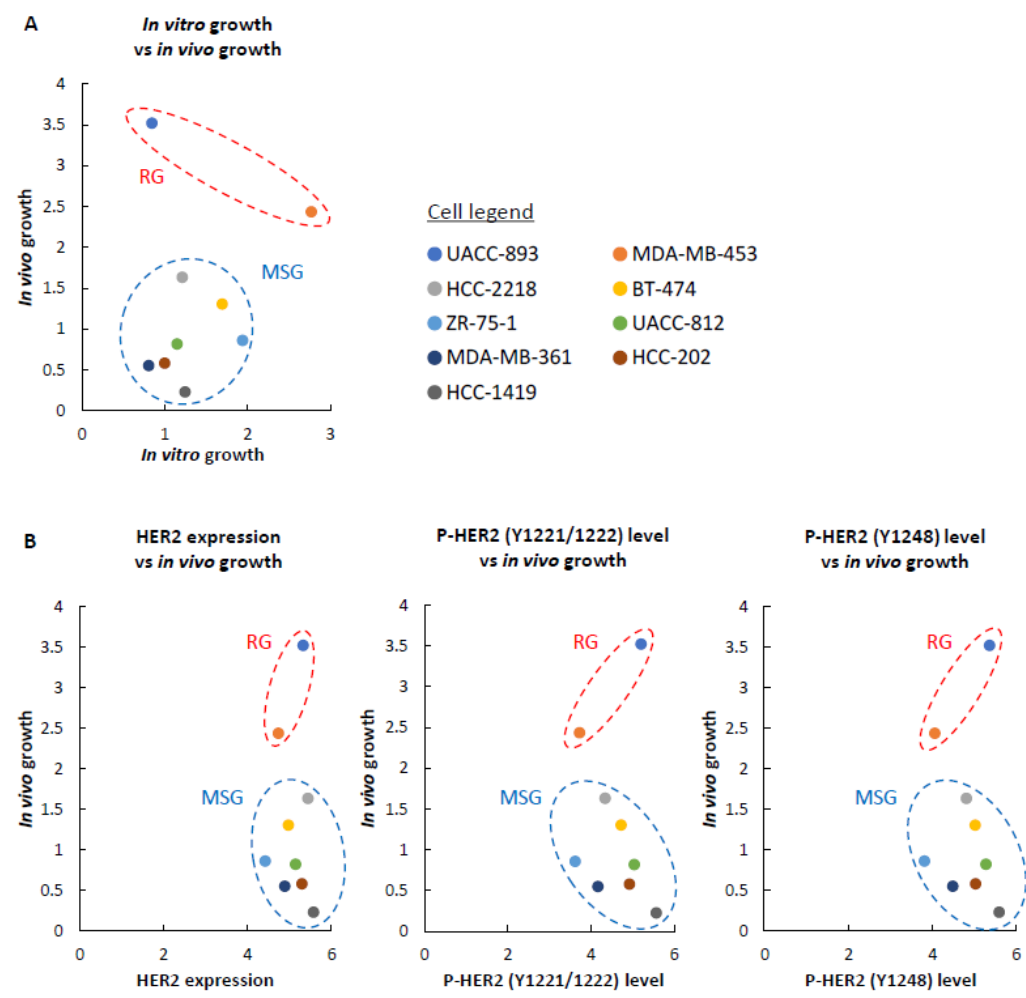
Figure 2. The relationship between in vivo growth and in vitro growth, in vivo growth and HER2 profiles. In all graphs, the vertical axis represents in vivo growth, which is presented on a log10 scale (mean normalized average radiance (ratio) on day 28). ( A ) The relationship between brain-colonizing ability and proliferative activity in vitro. The horizontal axis represents in vitro growth. The cell number on day 4 was converted to a log2 (N(4) / N 0 ) value for three replicates and their mean value was defined as in vitro growth. N(4) = The cell number on day 4. N 0 = The number of cells seeded on day 0 ( = 1.5 × 10 5 cells). ( B ) The contribution of HER2 expression and HER2 phosphorylation to growth activity in vivo. The horizontal axis represents HER2 expression, P-HER2 (Y1221 / 1222) level, and P-HER2 (Y1248) level. Each band intensity in Figure S1B was quantified as a raw integrated density (RawIntDen) using ImageJ. The RawIntDen measured by ImageJ was converted to a log10 (RawIntDen) value for HER2 expression, the P-HER2 (Y1221 / 1222) level, and the P-HER2 (Y1248) level.